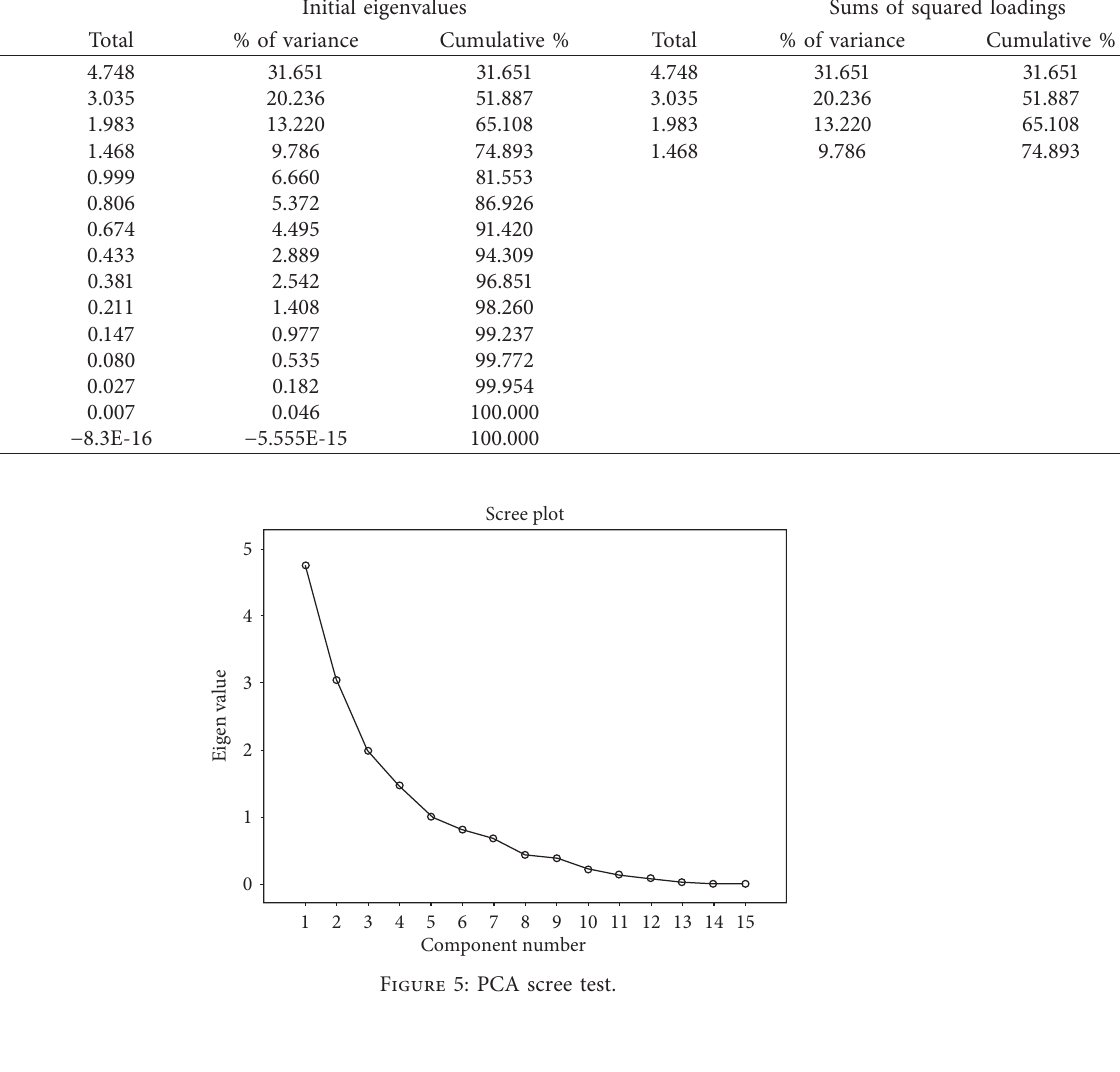
Table 6: Component